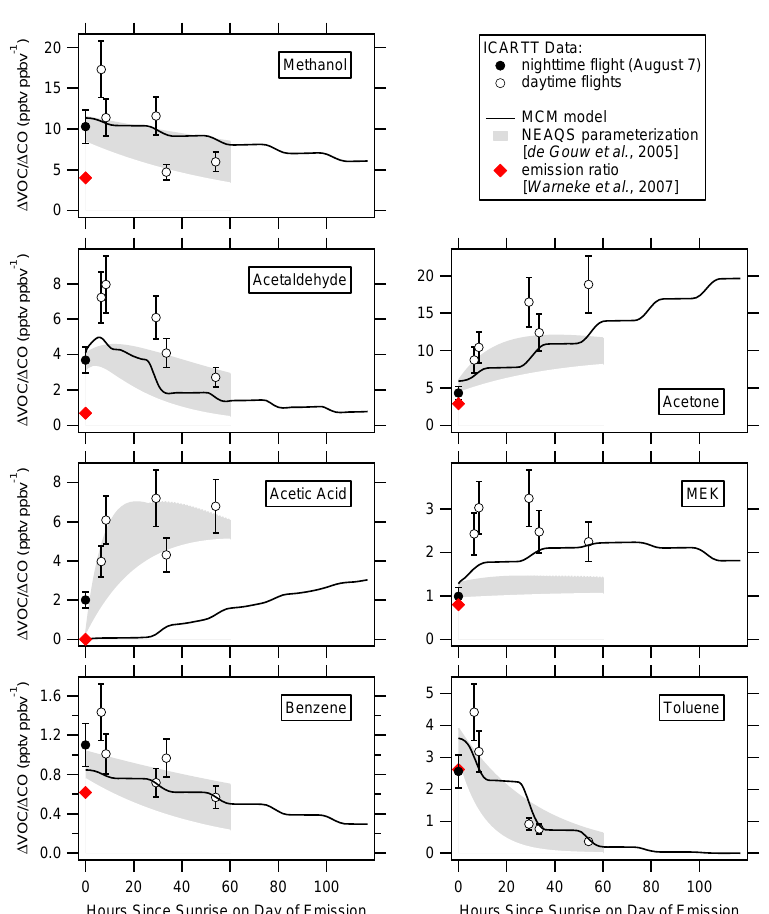
Fig. 5. Measured VOC enhancement ratios from six different flights downwind from New York City as a function of the transport time. Also shown are the calculation of the VOC enhancement ratios as a function of processing time using the MCM model (solid curve), the NEAQS parameterization (Fig. 2) of enhancement ratios as a function of photochemical age – with the grey area representing the range of possible values due to uncertainties in average OH and in the acetylene/CO emission ratio – and the emission ratio according to Warneke et al. (2007).